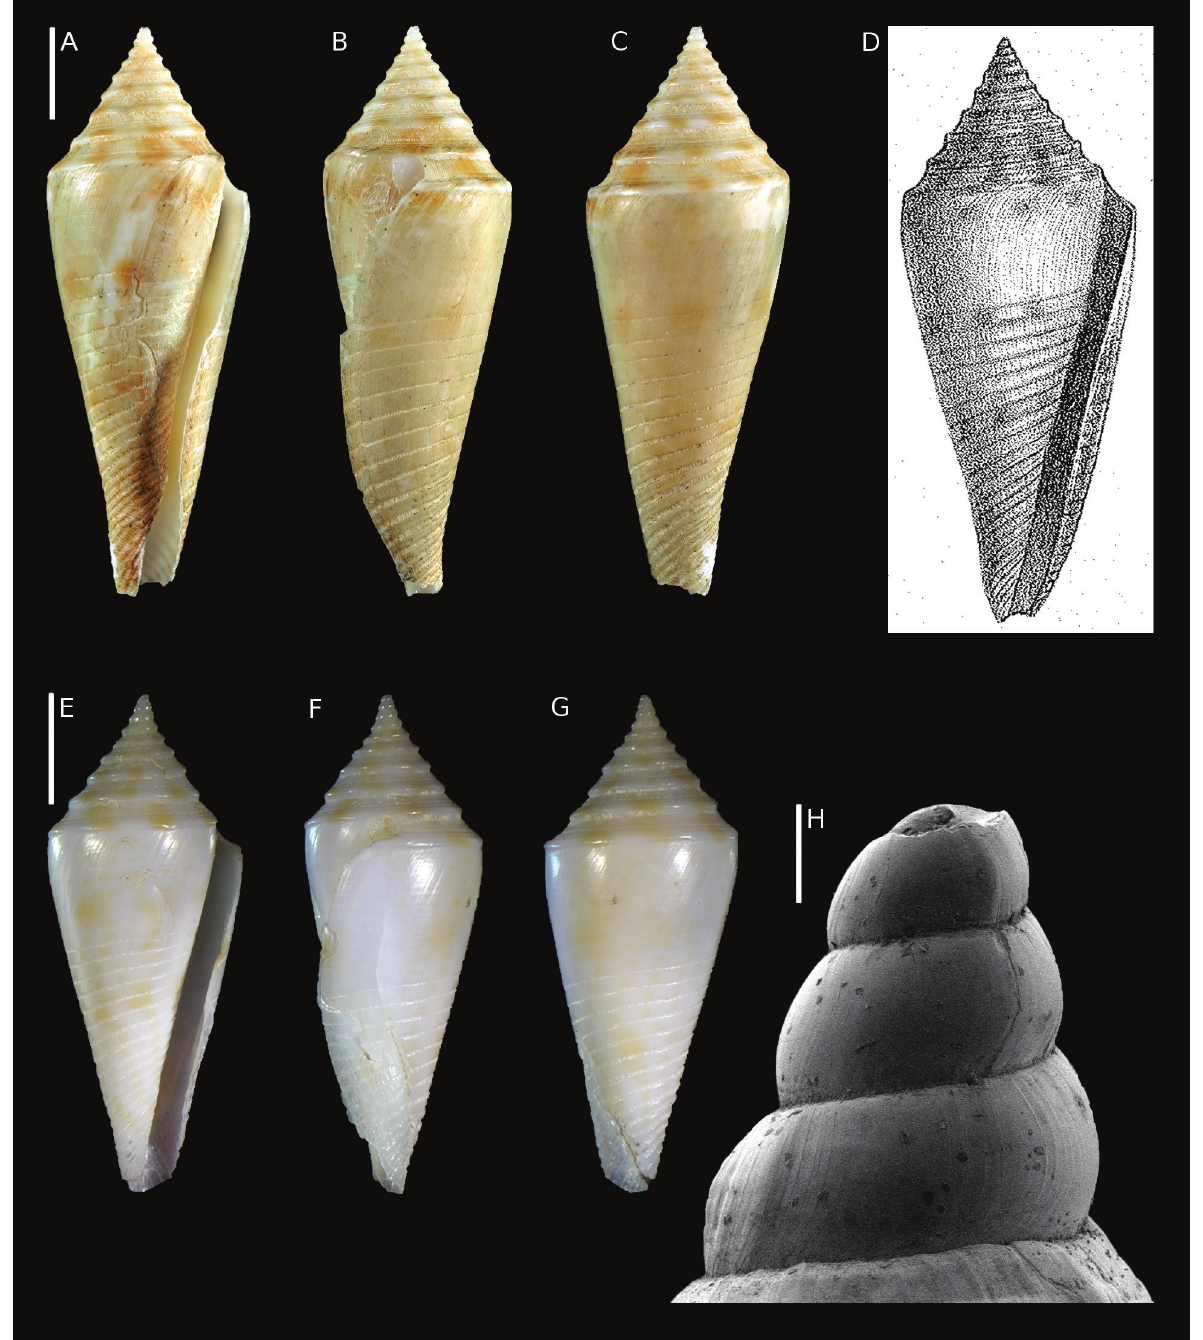
Figure 26. Conus aculeiformis var. torensis Sturany, 1903, Station 88 (El Tor, Egypt, Red Sea). A–C . Figured syntype, NHMW 84223: front ( A ), right side ( B ), back ( C ). E–H . Syntype, NHMW 84224: front ( E ), right side ( F ), back ( G ), protoconch ( H ). D . Original figure by Sturany (1903). Scale bars: A–C , E–G : 5 mm, H : 0.2